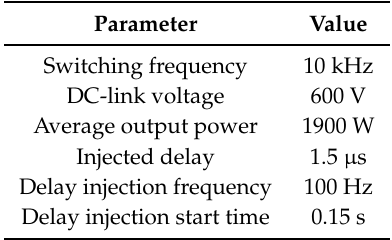
Table 4. Simulation